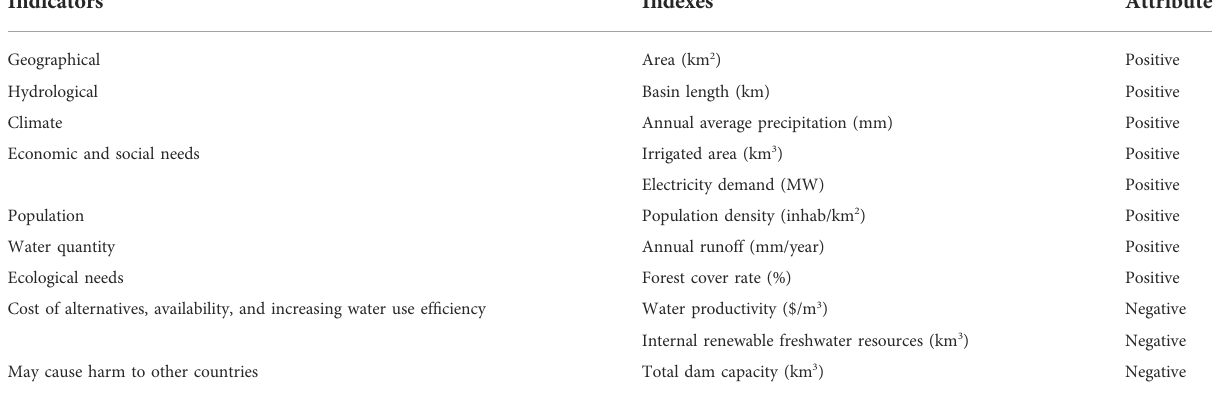
TABLE 1 Index for computing water circumstances of riparian countries.